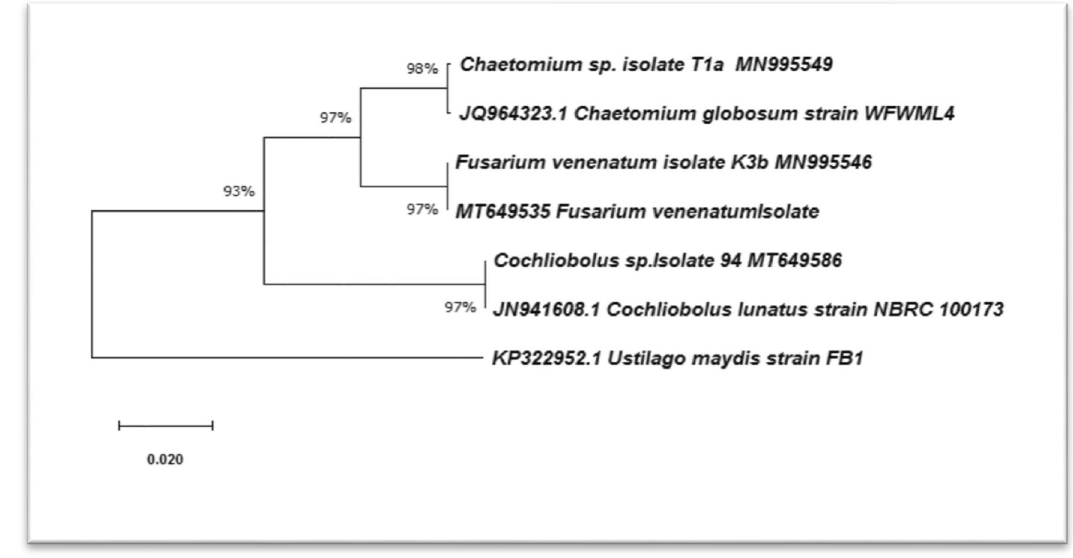
Figure 3. Phylogenetic tree of fungi isolates based on 18S ribosomal DNA.